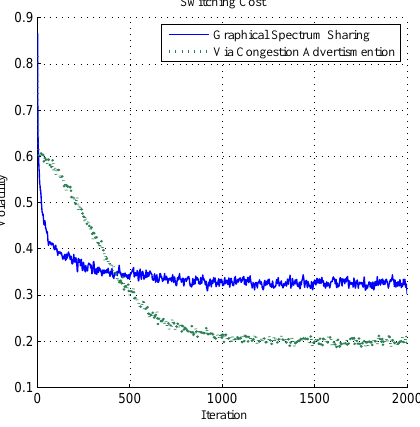
Figure 5. Network volatility improvement (as a convergence criteria) comparing with graphical spectrum sharing, B = 4 , homogeneous spectrum quality θ = [1 / 4 1 / 4 1 / 4 1 / 4] , simulation has averaged over 15 realization, α in RLA learning for each case has selected so that it shows the best performance possible in the shown region, utility format is U i ( A ( i, a θ ai . ρ ai (1+ |I i | )